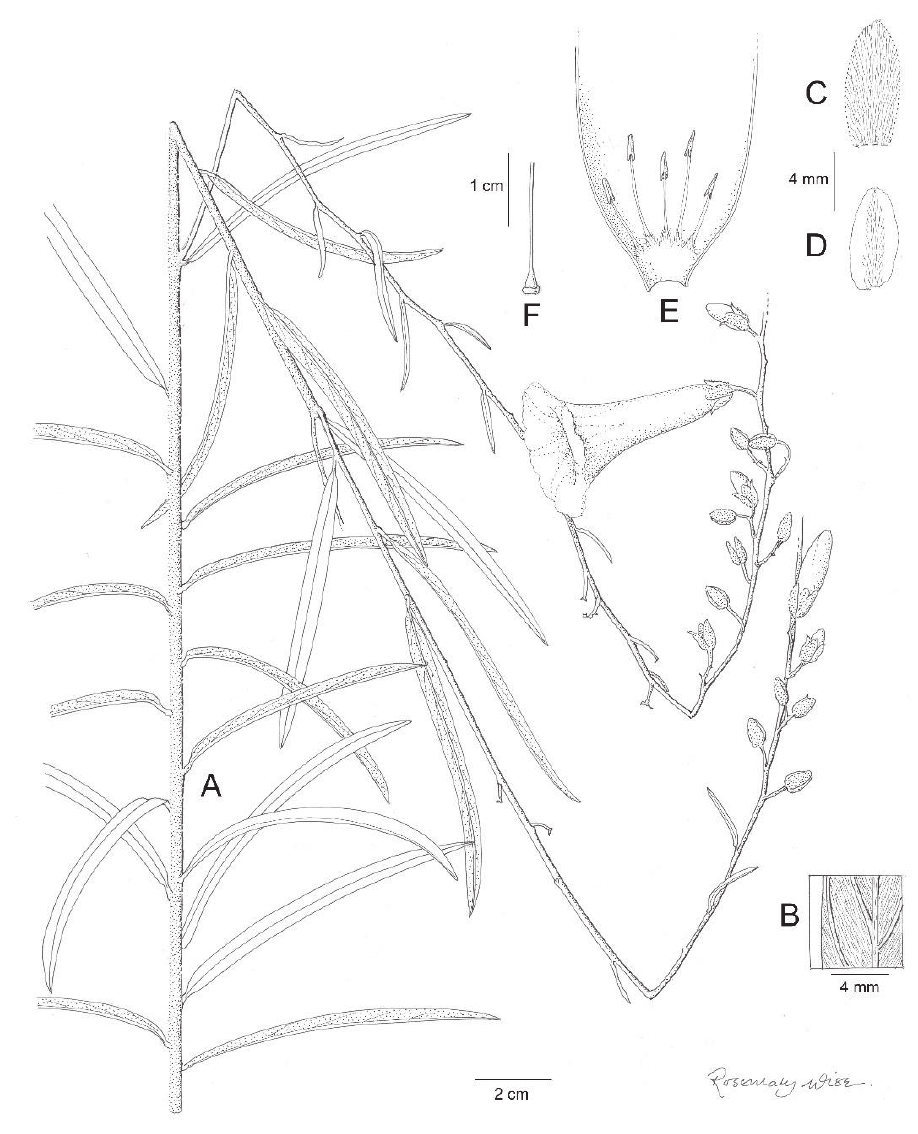
Figure 16. Ipomoea uninervis . A habit B abaxial leaf C outer sepal D inner sepal e corolla opened out to show stamens F ovary and base of style. Drawn by Rosemary Wise from C. Proença et al. 2074.